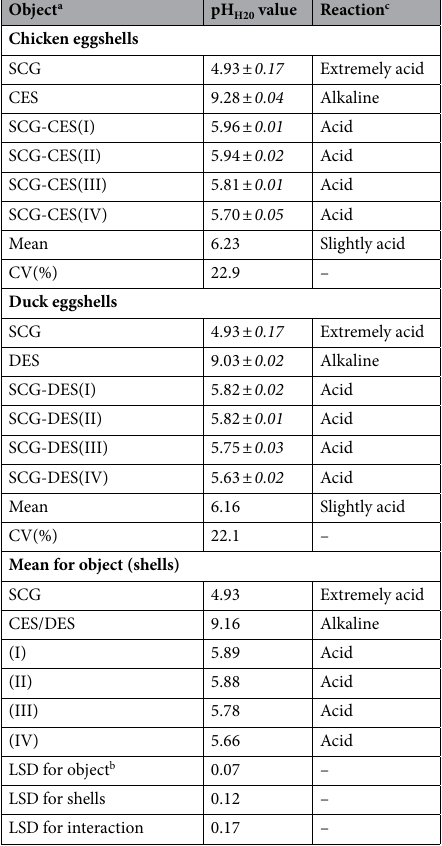
Table 5.. pH values of study objects after a 3-month incubation. a Explanations in Table 2. b LSD Least significant difference. c The reaction of fertiliser objects (mixtures) was based on the degree of soil